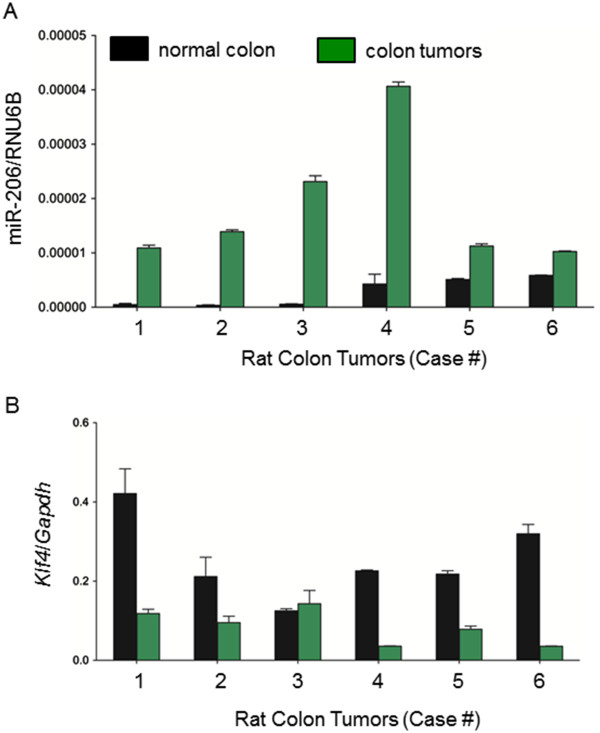
miR-206 and Klf4 expression in rat colon tumors. Carcinogen-induced colon tumors and adjacent normal-looking colonic mucosa from a prior study
[22] were examined for (A) miR-206 expression, normalized to RNU6B, and (B) Klf4 mRNA expression normalized to Gapdh. For the six colon tumors shown, data bars indicate mean ± SD, n = 3.